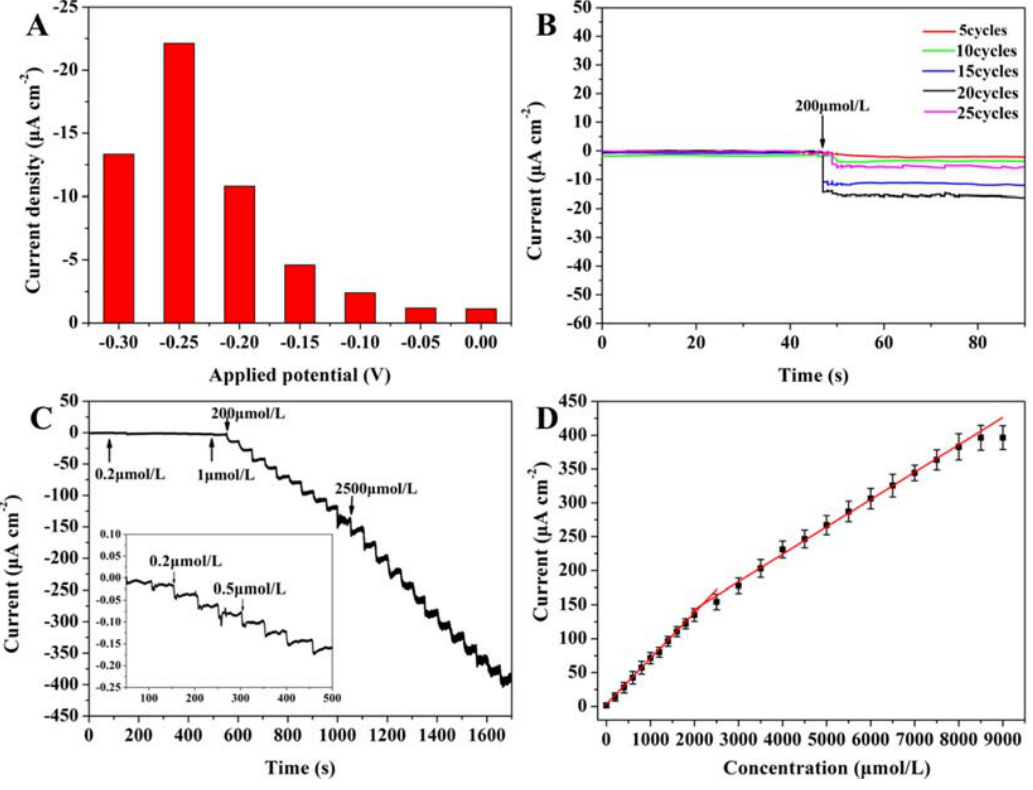
Figure 7. ( A ) Histograms of the current responses of Pt/rGOP electrode to 0.2 mmol/L H 2 O 2 in PBS at a different applied potential. ( B ) Amperometric responses of the different deposition cycles on Pt/rGOP electrode to 0.2 mmol/L H 2 O 2 in PBS at − 0.25 V. ( C ) Typical amperometric response of Pt/rGOP electrode to successive additions of different hydrogen peroxide concentrations in PBS (pH 7.4) with magnetic stirring and its ( D ) calibration curve. Table 1. Comparison of various graphene ‐ based electrodes for H 2 O 2 sensing.